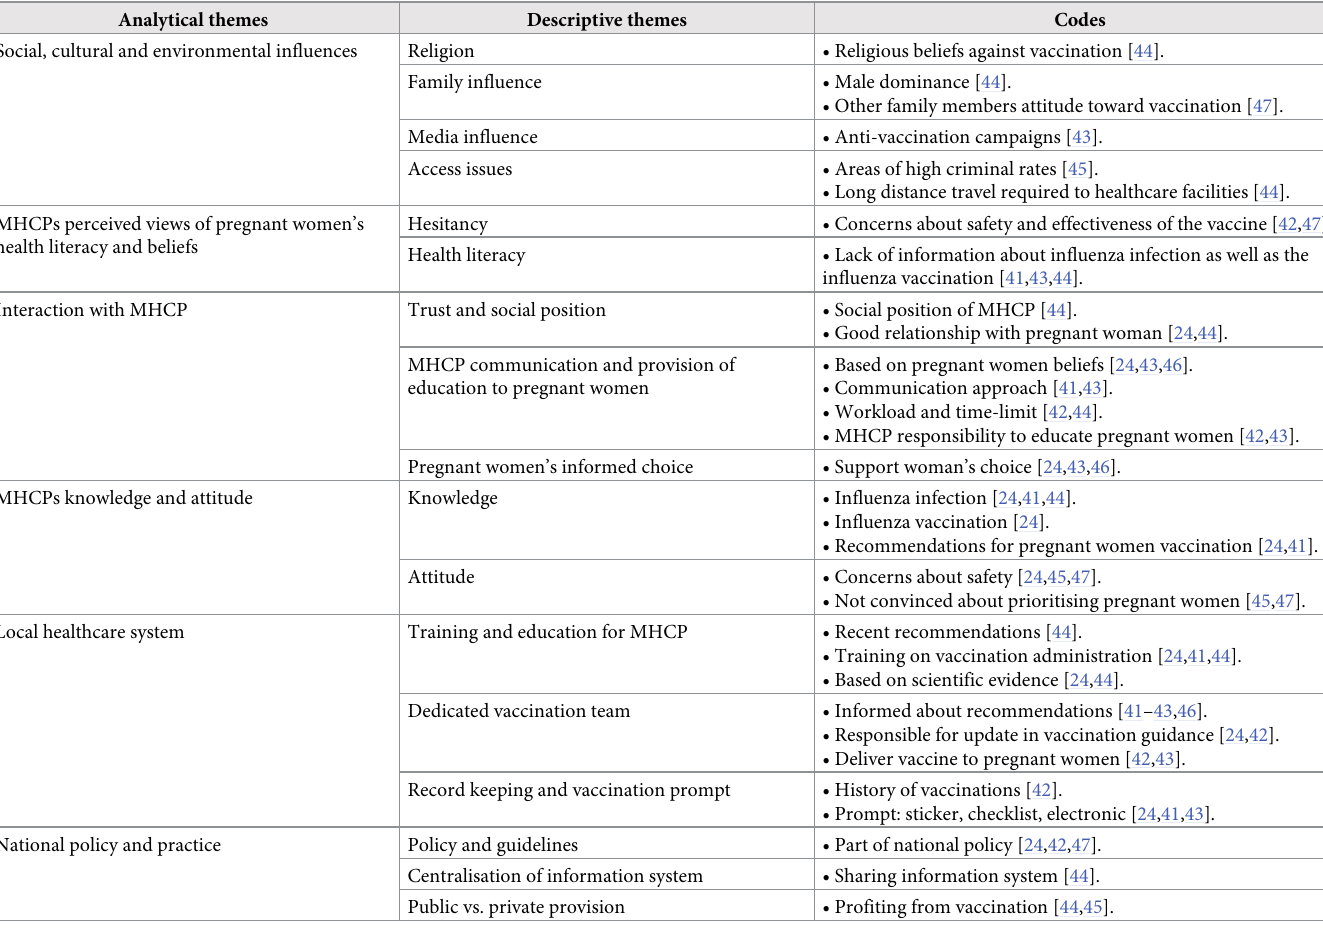
Table 3. Core analytical and descriptive themes for MHCPs’ experiences and views relating to the provision of influenza vaccination for pregnant